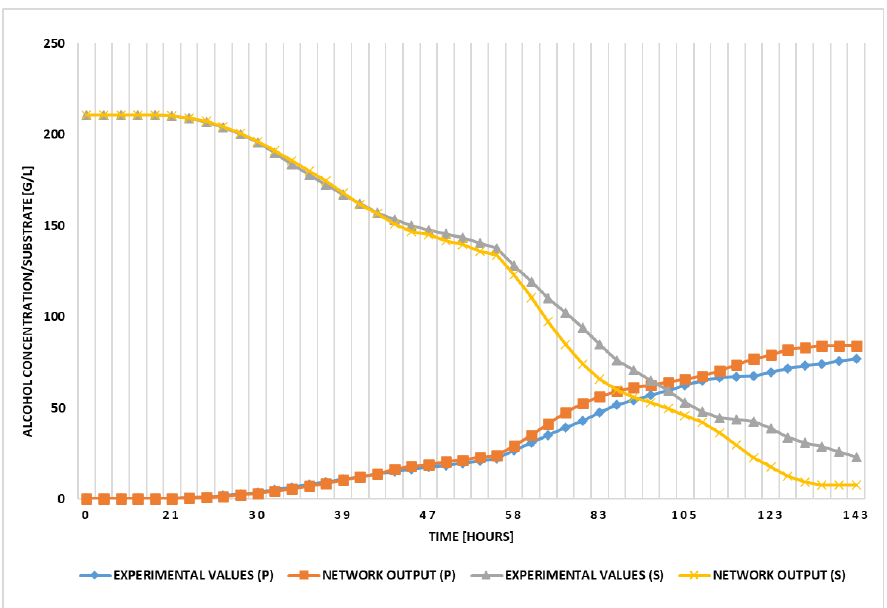
Figure 10. Generated results by the NN vs. experimental values using the third variant input-output configuration of NN.